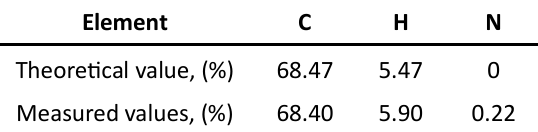
Table 1. Elemental analysis data of compound